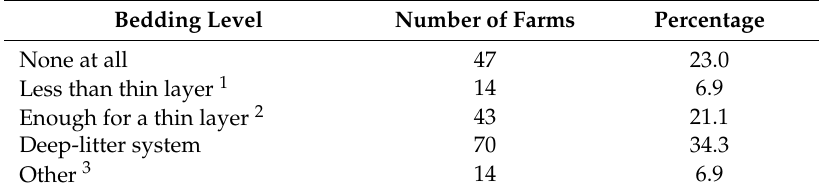
Table 2. Distribution of farms using di ff erent levels of